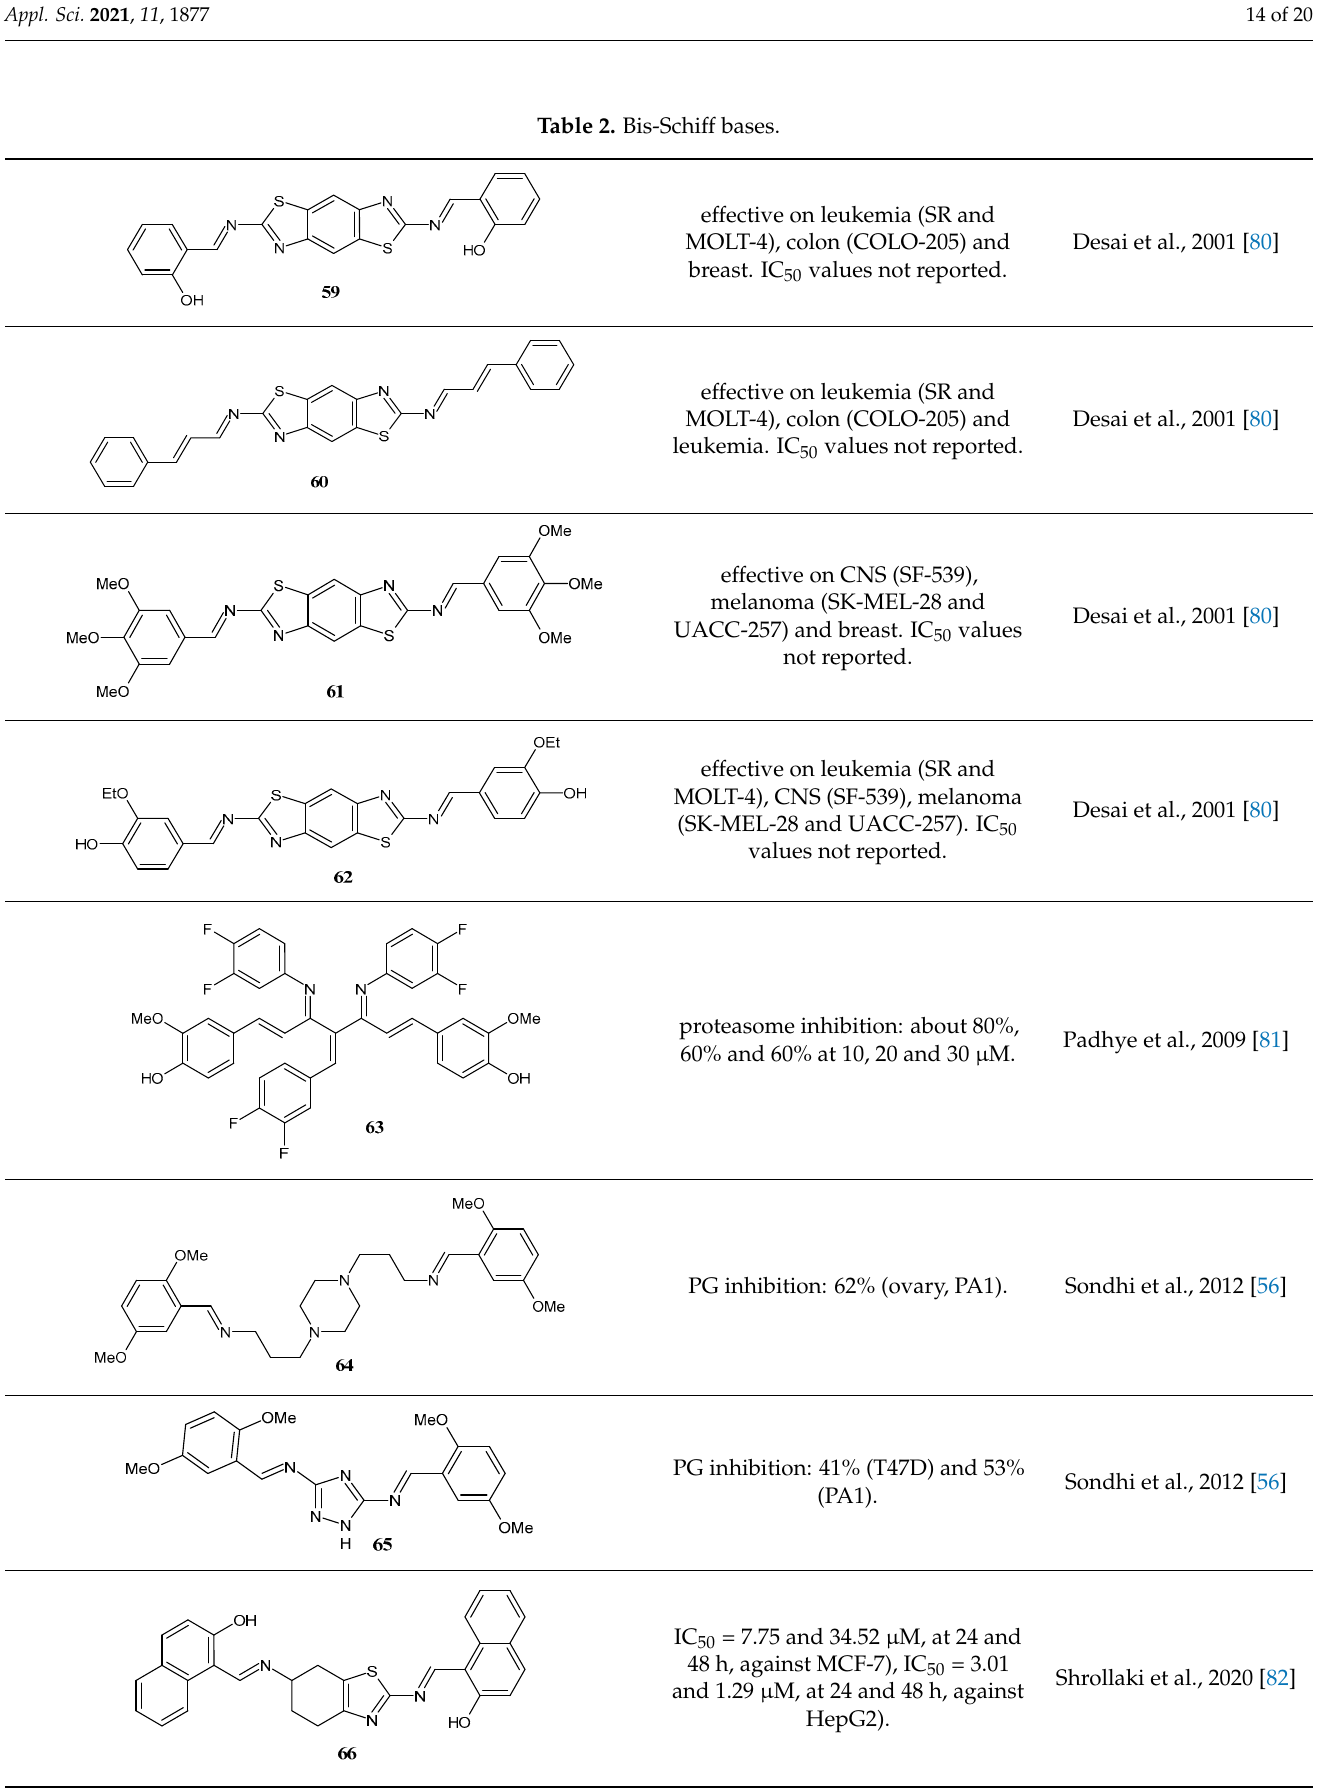
Table 2. Bis-Schiff bases.